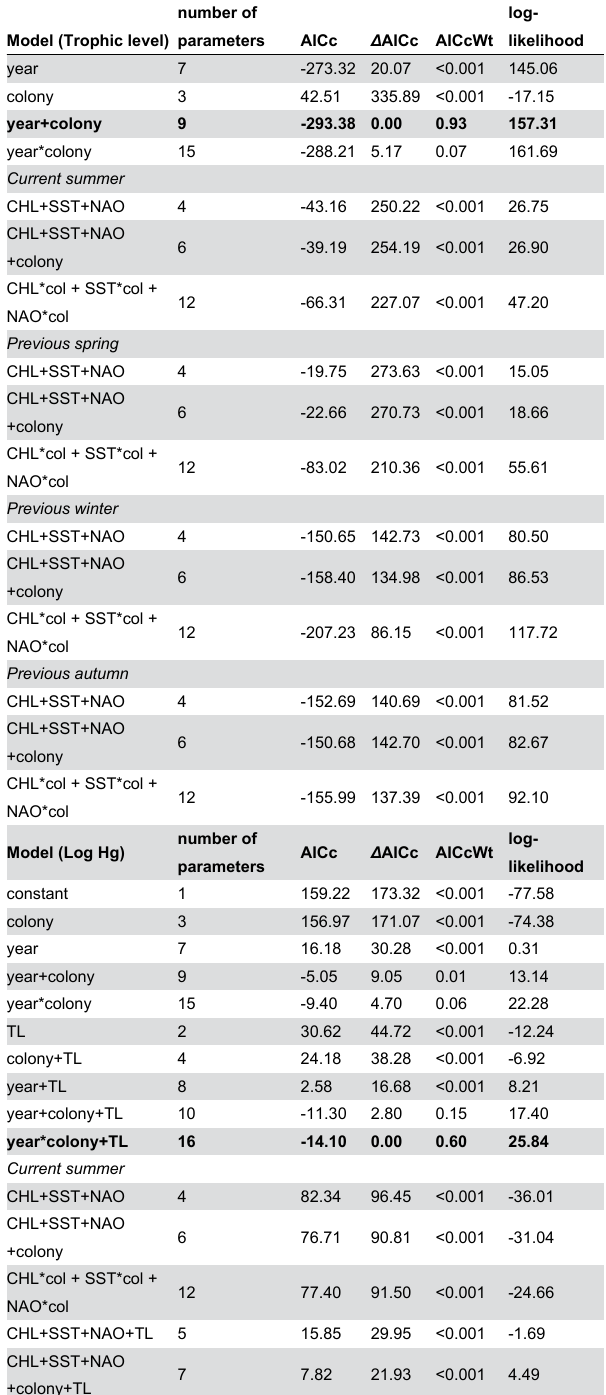
Table 2. Associated measures of information to a number of parameters of the different candidate models evaluated to fit the data corresponding to the trophic level and mercury concentration (log